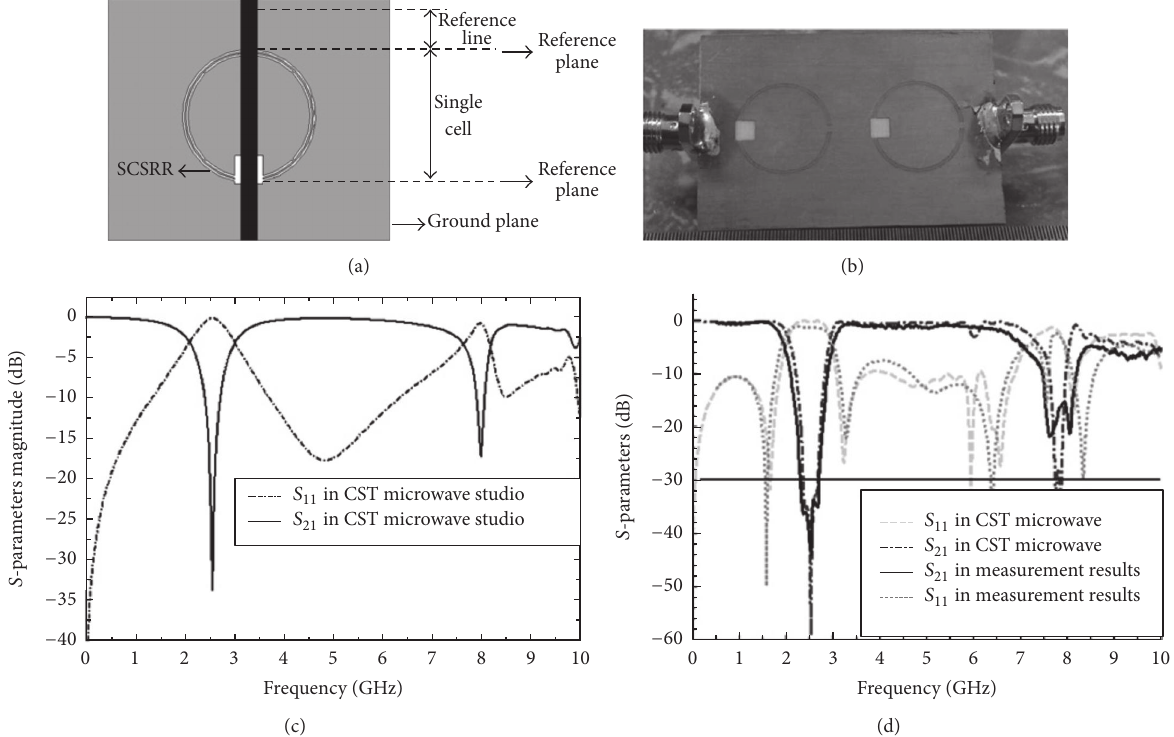
Figure 16: SCRR loaded band-stop filter: (a) single unit schematic, (b) double unit prototype, (c) single unit response, and (d) double unit response